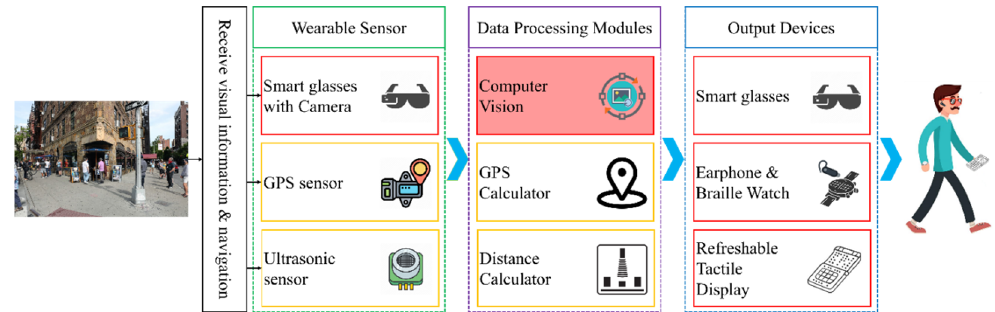
Figure 1. The structure of a wearable navigation system with smart glass and refreshable tactile display.